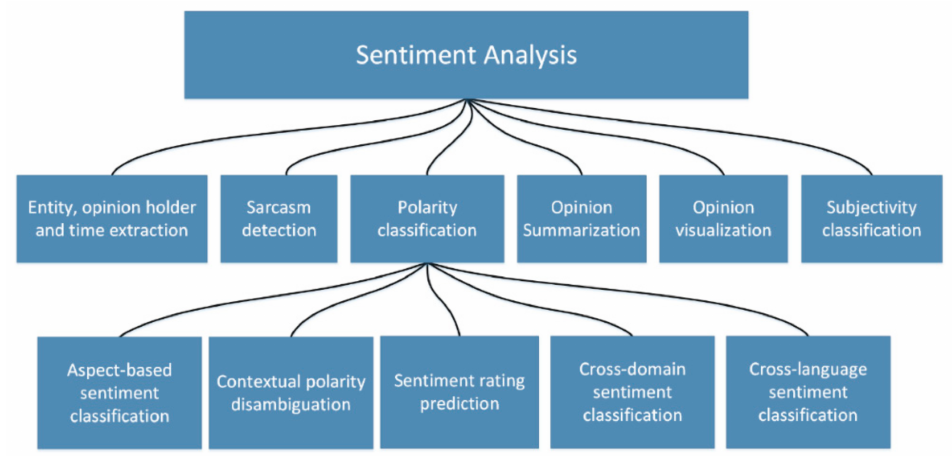
Figure 1. Sentiment analysis tasks as listed by Pozzi et al.